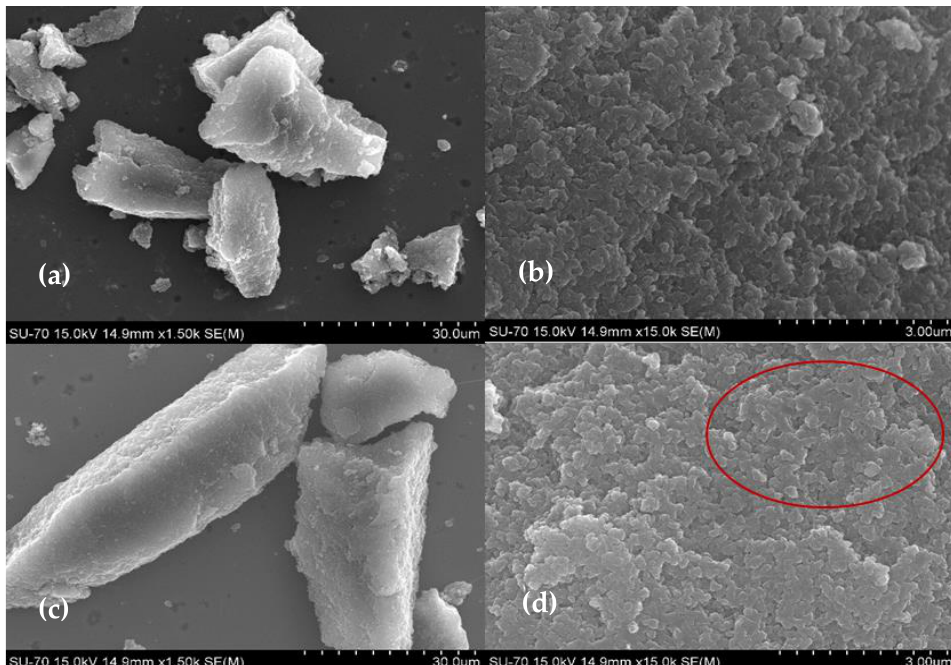
Figure 1. SEM images of CX-4 ( a , b ) and ASNase-CX-4 bioconjugate ( c , d ).